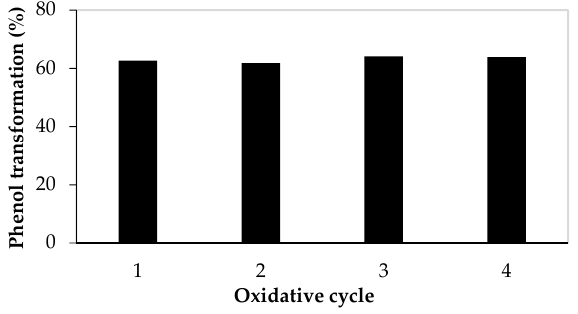
Figure 2. Phenol transformation in subsequent cycles of enzymatic treatment with laccase immobilized onto FeO-2206W (pH 6).